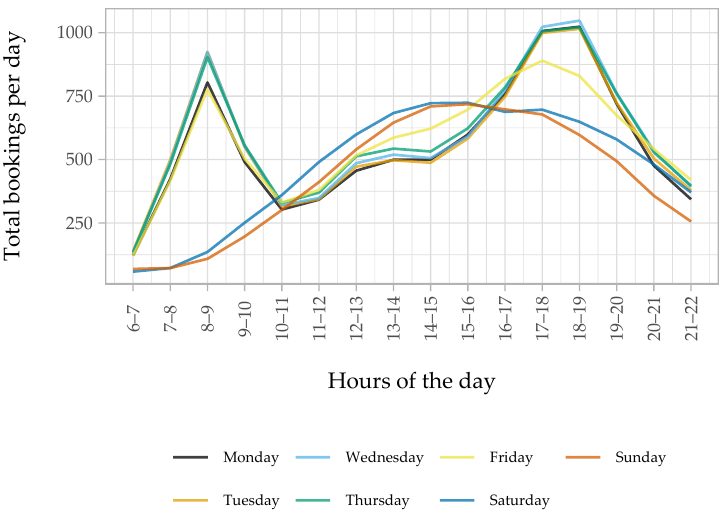
Figure 6. Hourly distribution of bookings for a